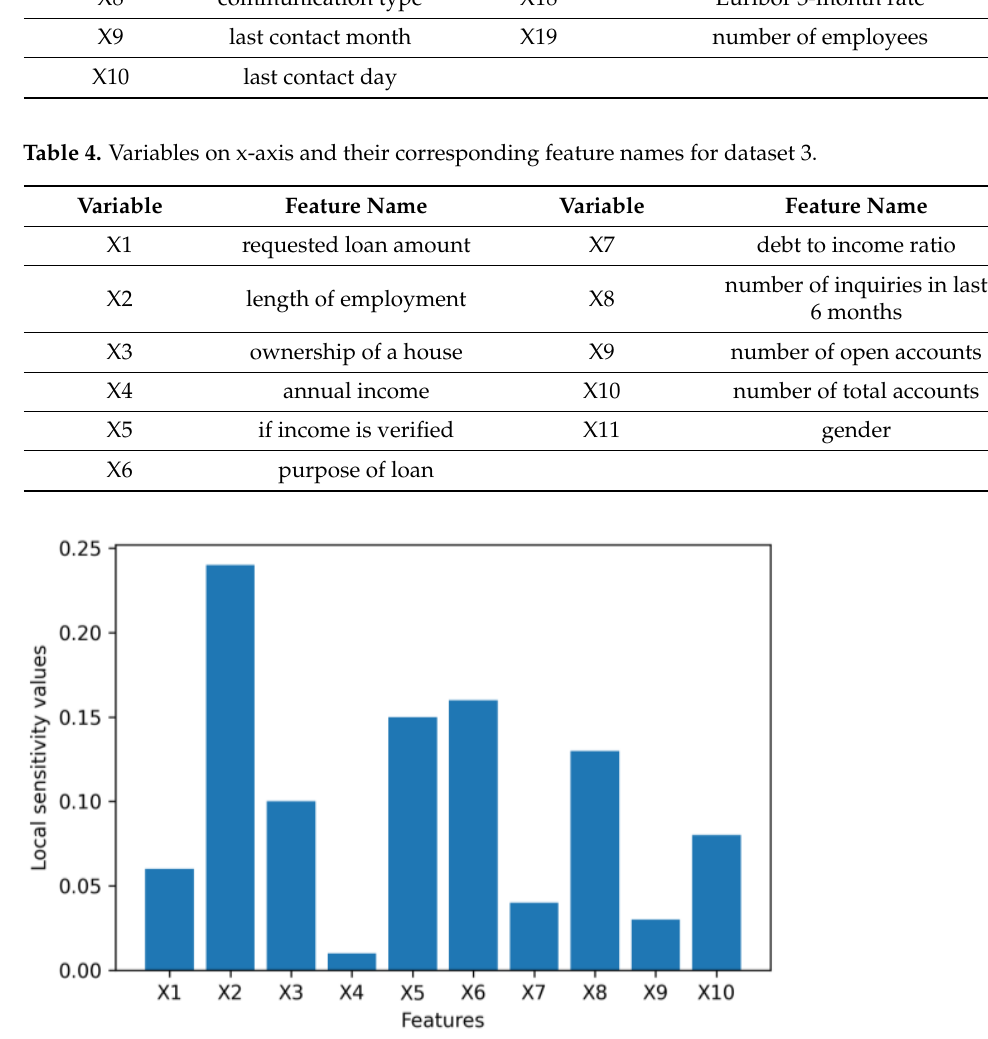
Table 4. Variables on x-axis and their corresponding feature names for dataset 3.